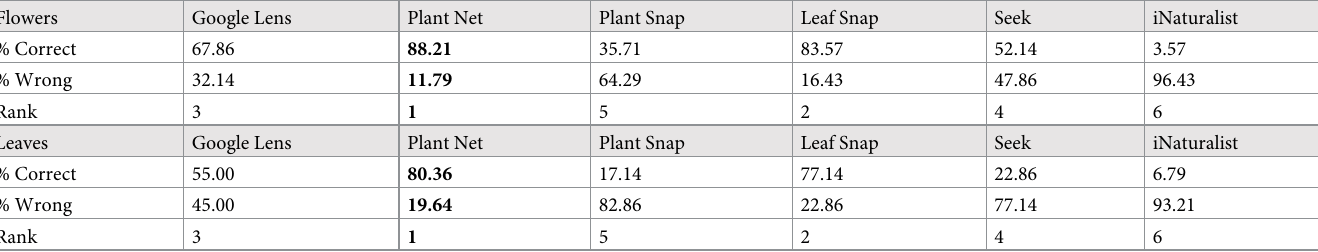
Table 4. Percentages of leaves and flowers where the first suggestion is a correct species identification (N = 280). Flowers Google Lens